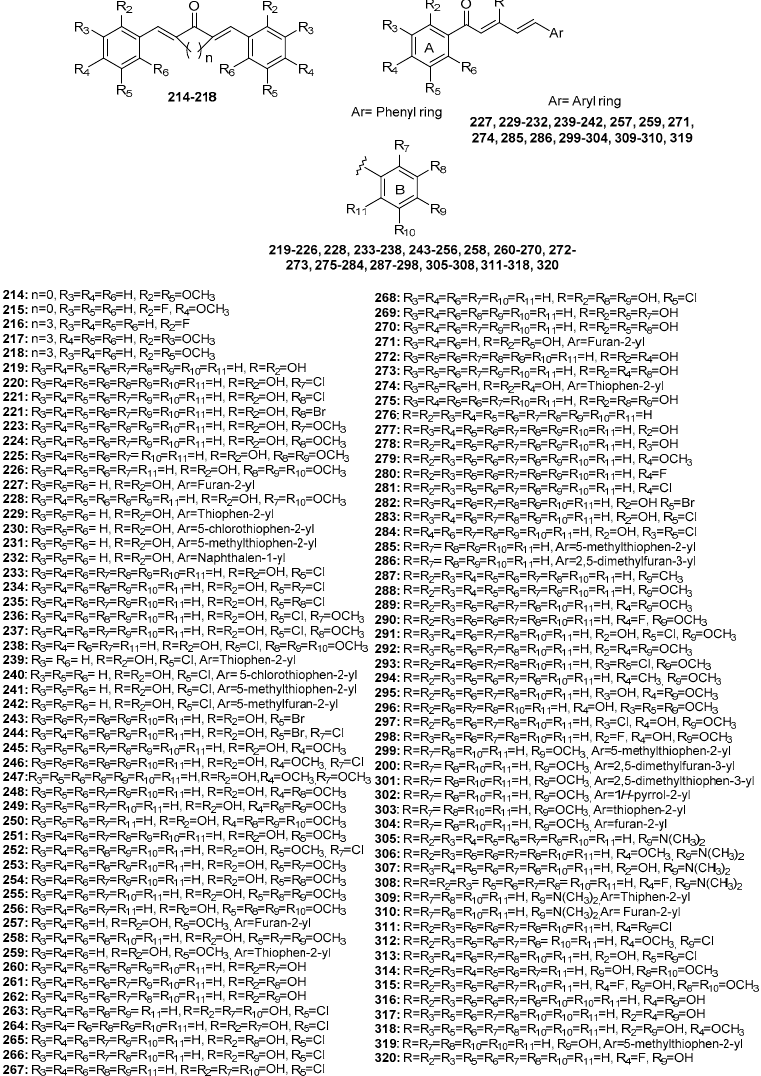
Figure 8. Synthetic diarylpentanoids with promising inhibition of NO production.